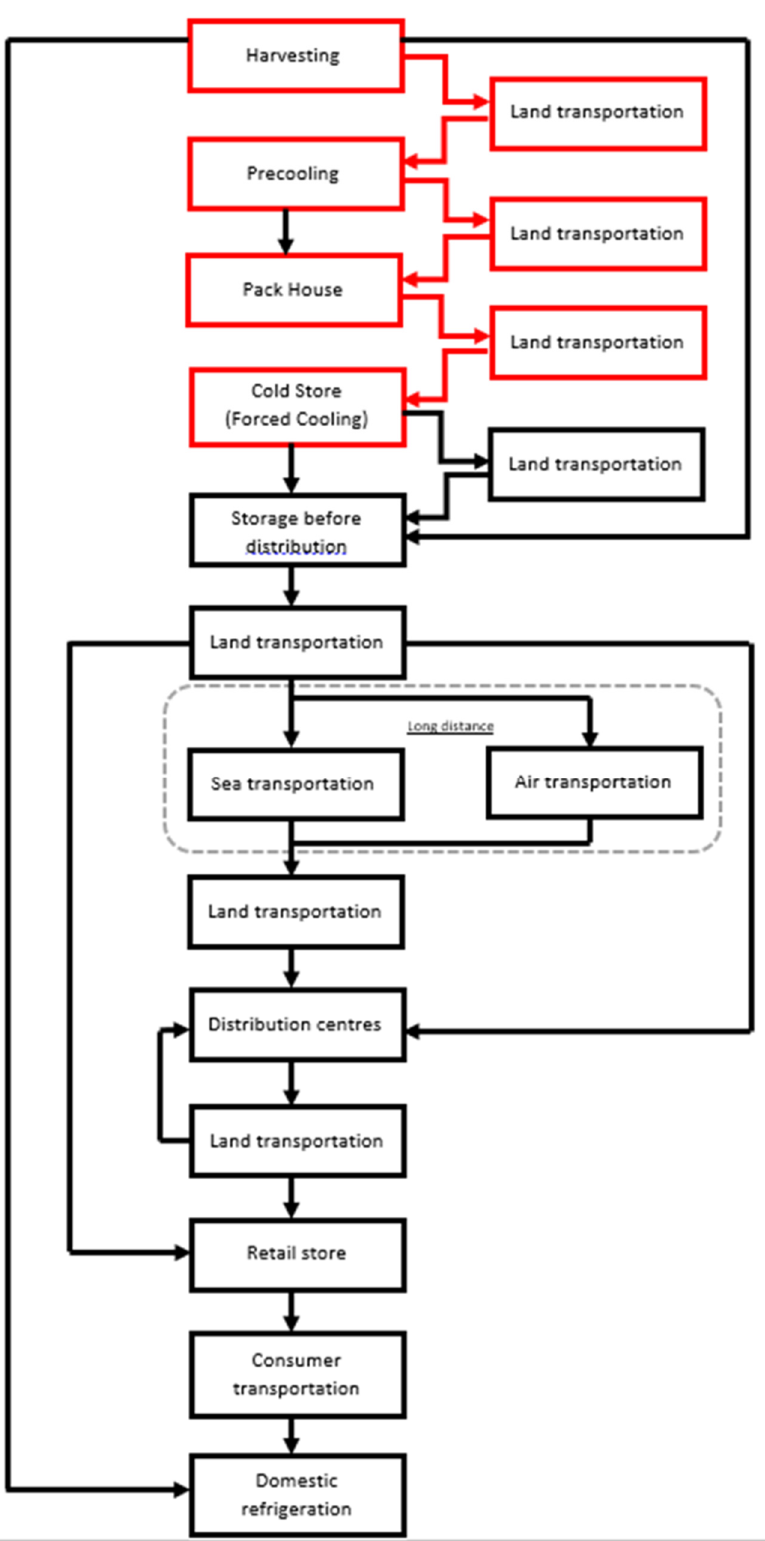
Figure 1. Overview of the main steps in a typical cold chain . Source: adapted from [12].